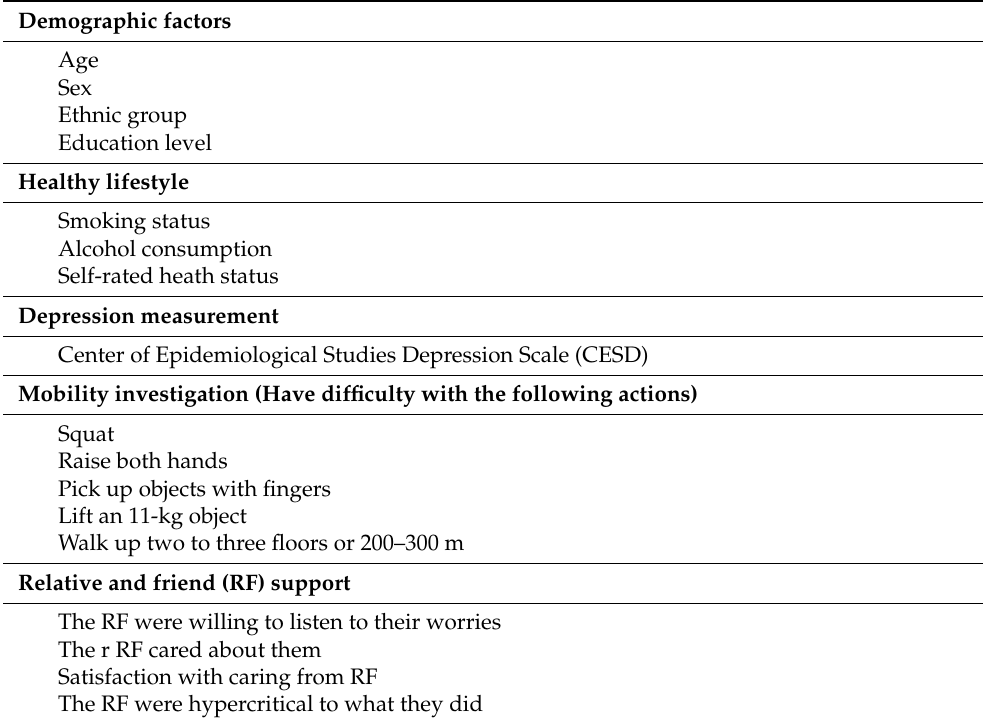
Table 1. Dimensions measured in the questionnaire.